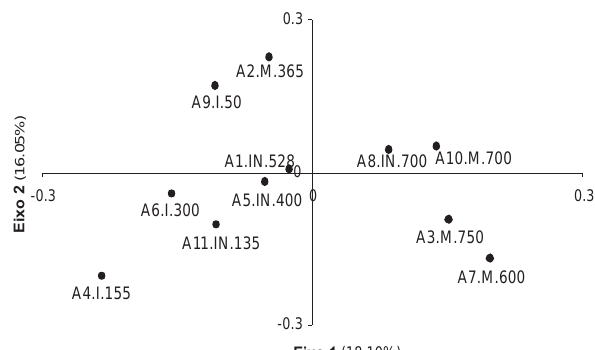
tion of these variables in relation to axis 1 of the CA (Fig. 2 and Tab. III) reveals that fragment areas in Group 1 tend to have